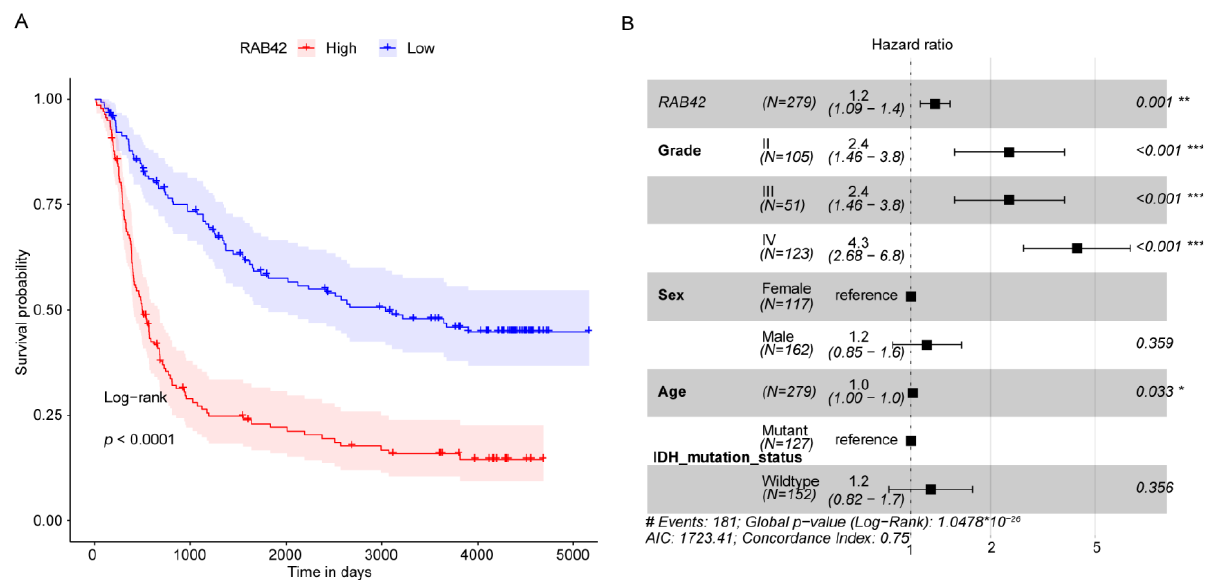
Figure 3. The highly RAB42 expressed GBM patients had a worse prognosis. ( A ) Kaplan–Meier (KM) survival curve of GBM patients with high and low RAB42 expression. ( p determined by log-rank). ( B ) Results of the multivariate Cox regression analysis. * p <0.05, ** p < 0.01, *** p < 0.001.